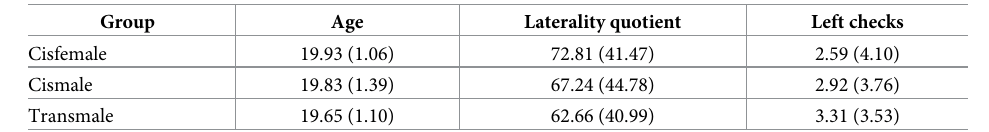
Table 1. Mean age and handedness for participant